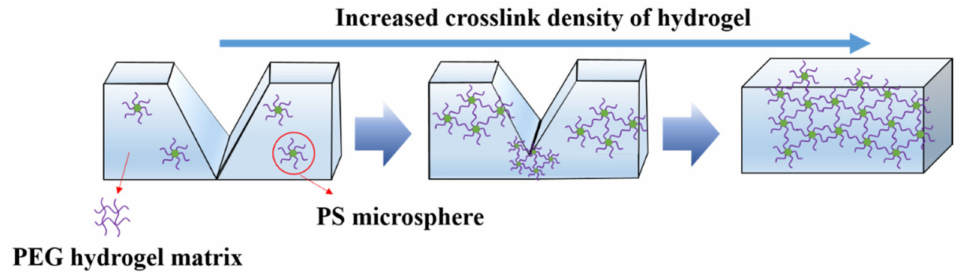
Figure 17. Influence of PS microspheres content on fracture